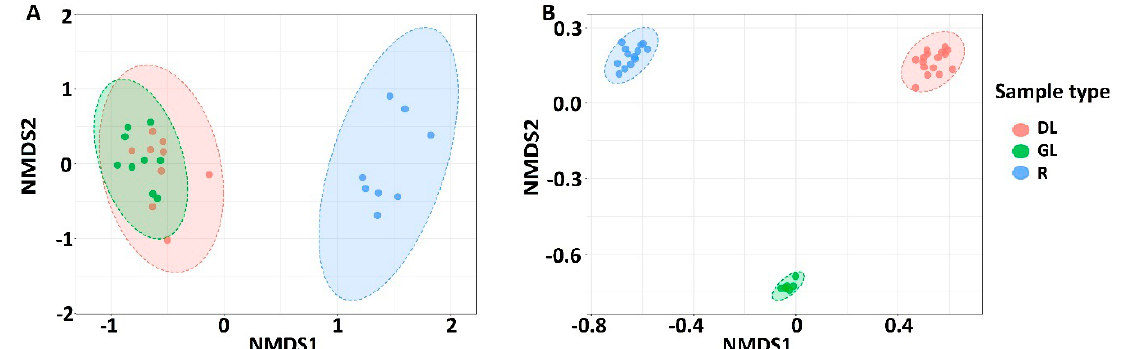
Figure 3. Nonmetric multidimensional scaling (NMDS) analysis of the fungal ( A ) and bacterial ( B ) communities of winter rye plants affected by the snow mold disease. Desiccated dead parts of leaves (DL, red), green parts of leaves (GL, green), and roots (R, blue) were analyzed separately on the basis of Bray–Curtis distance. Statistical analysis of group similarities showed a significant difference between clusters DL / GL and R (PERMANOVA, p -value < 0.001) for the fungal dataset and among all clusters for the bacterial dataset (PERMANOVA, p -value < 0.001).